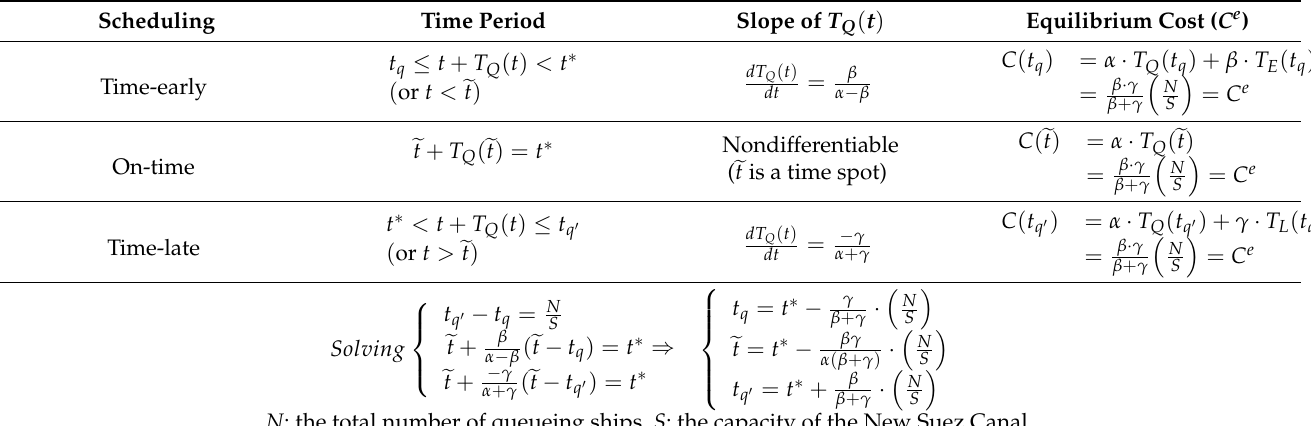
Table 2. Derivation of the no-toll